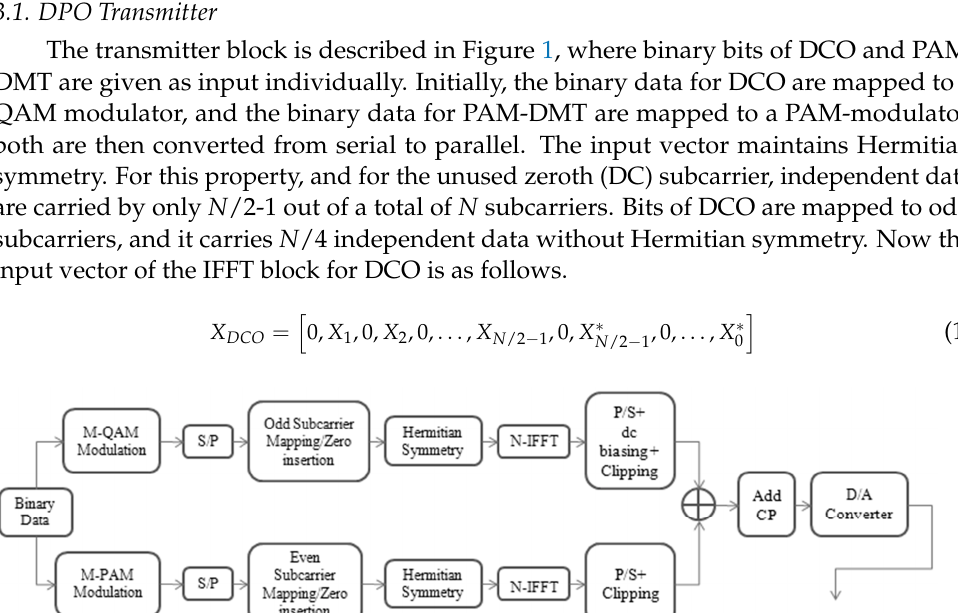
Figure 2. DC-biased pulse amplitude modulated orthogonal frequency division multiplexing (DPO-OFDM) receiver transforms the optical signal into electrical and then separates the dc-biased optical OFDM (DCO-OFDM) and pulse amplitude modulated discrete